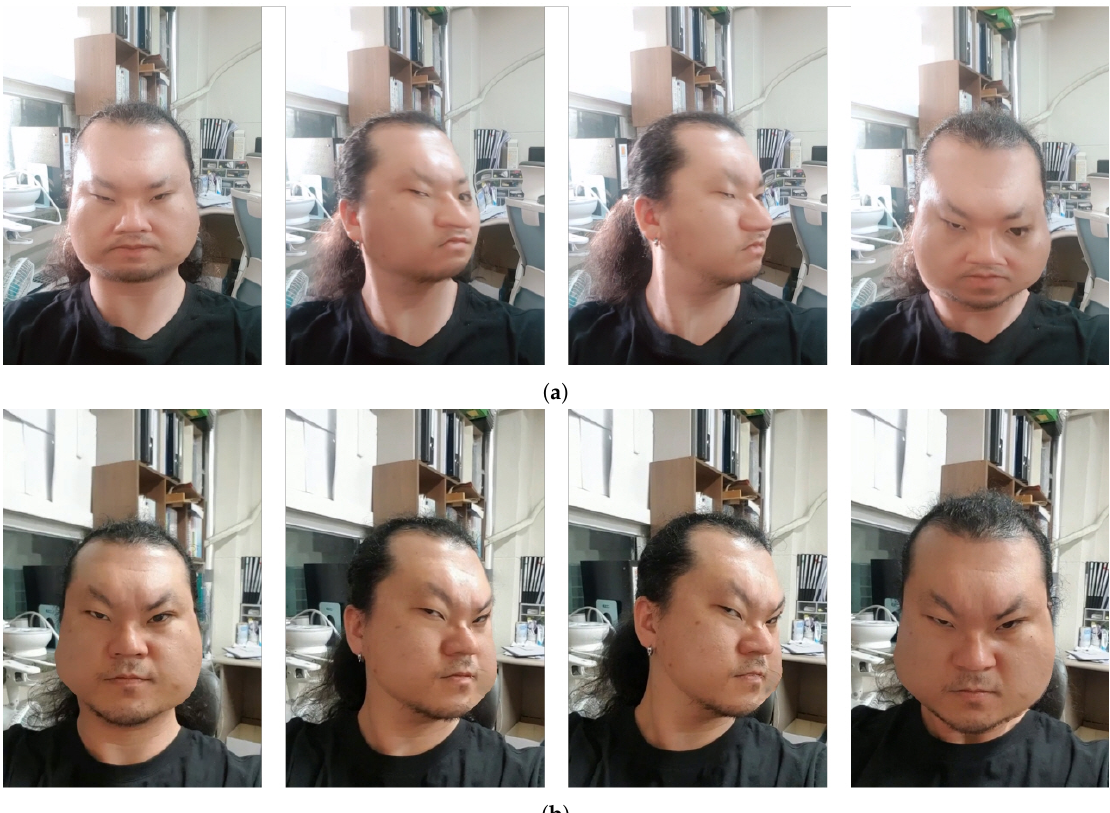
Figure 9. Comparison with existing application: ( a ) results from Snow; and ( b ) results from the proposed